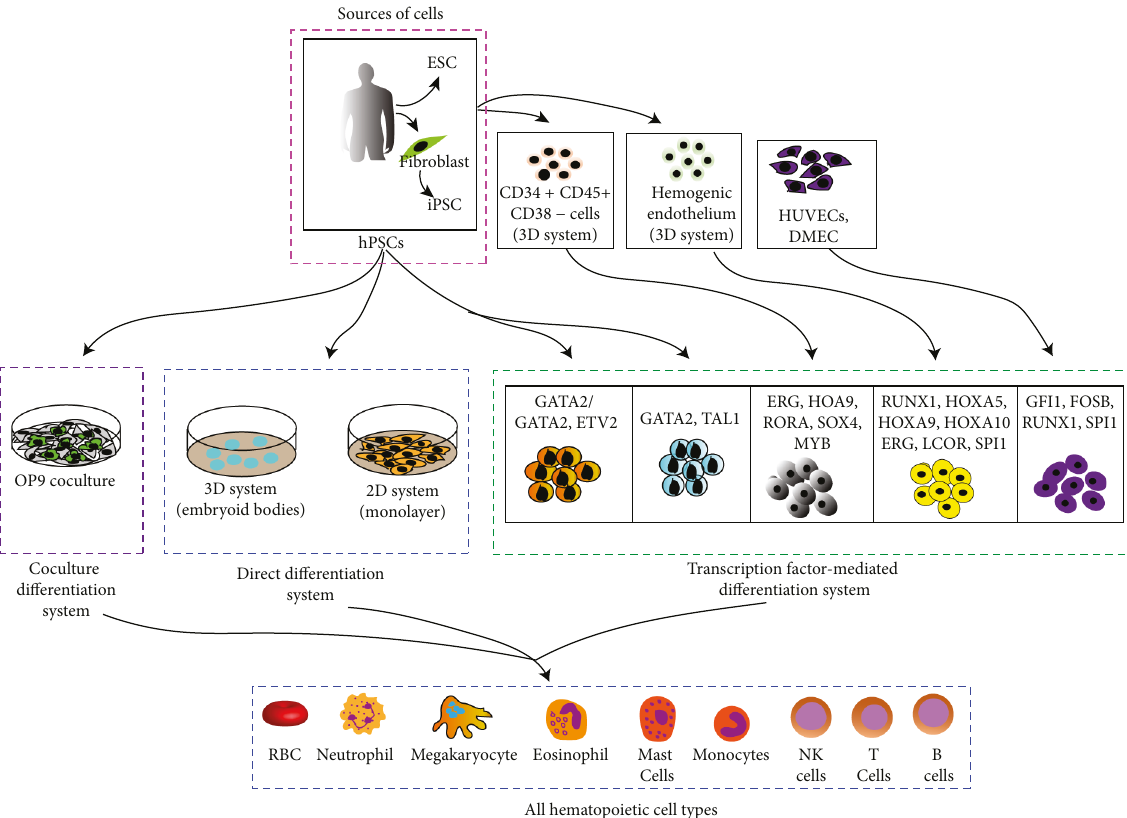
Figure 2: Hematopoietic di ff erentiation from hPSCs. Schematic summary of reported strategies for hematopoietic di ff erentiation from hPSCs. Human PSCs can be di ff erentiated into hematopoietic cells (HSCs) by three strategies: OP9 coculture, direct di ff erentiation, and transcription-mediated di ff erentiation